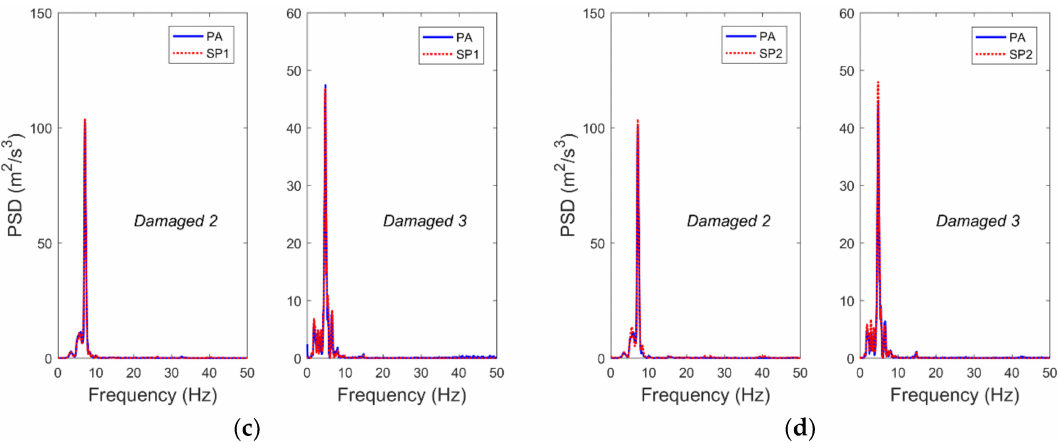
Figure 5. Using the acceleration time-history measurements from Figure 4, the power spectral density functions of ( a ) frame 1 and ( b ) frame 2 in the undamaged and damaged 1 cases, as well as ( c ) frame 1 and ( d ) frame 2 in the damaged 2 and damaged 3 cases are compared.